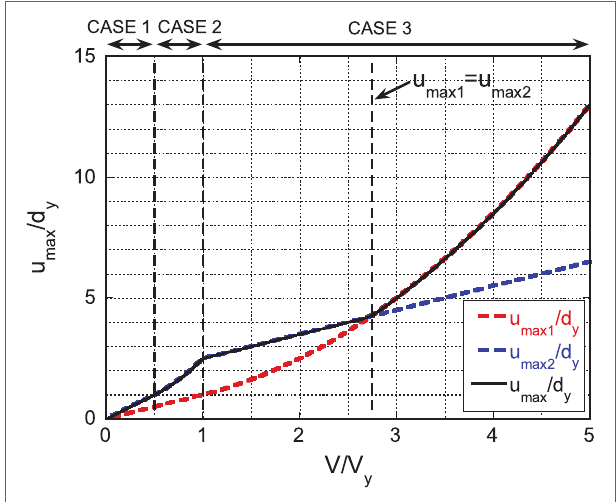
FigUre 4 | Maximum normalized elastic–plastic deformation under double impulse with respect to input level (Kojima and Takewaki,